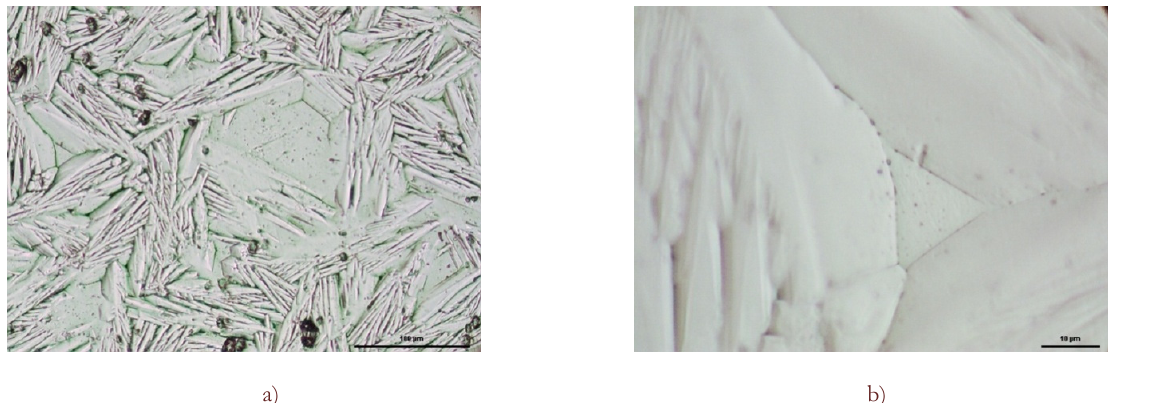
Figure 2: Initial austenitic microstructure of the investigated NiTi alloy: a) at low magnification showing the presence of inclusions, b) high magnification with presence of